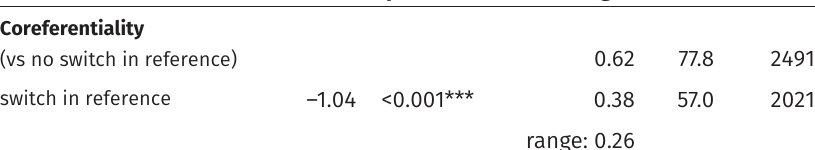
Table 17: The significance of the use of null subject for coreferentiality recoded (switch